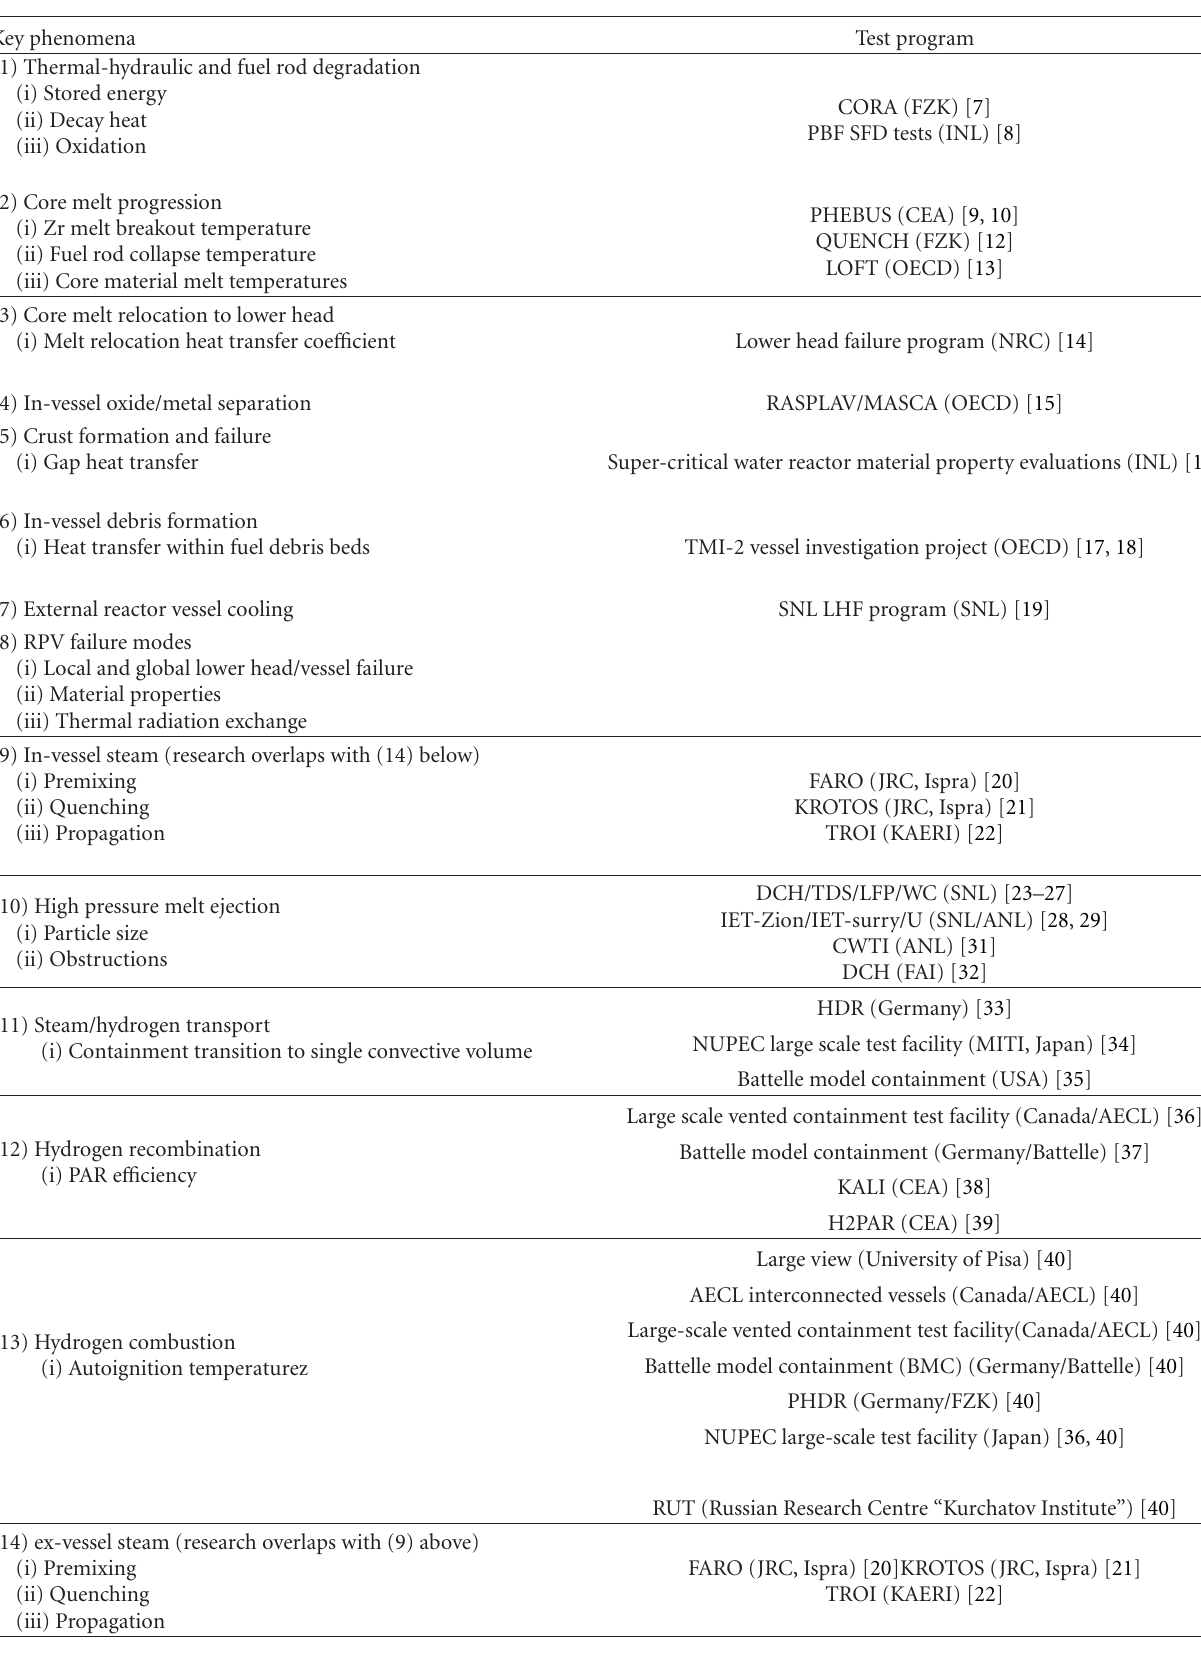
Table 2: Mapping of key severe accident phenomena to test